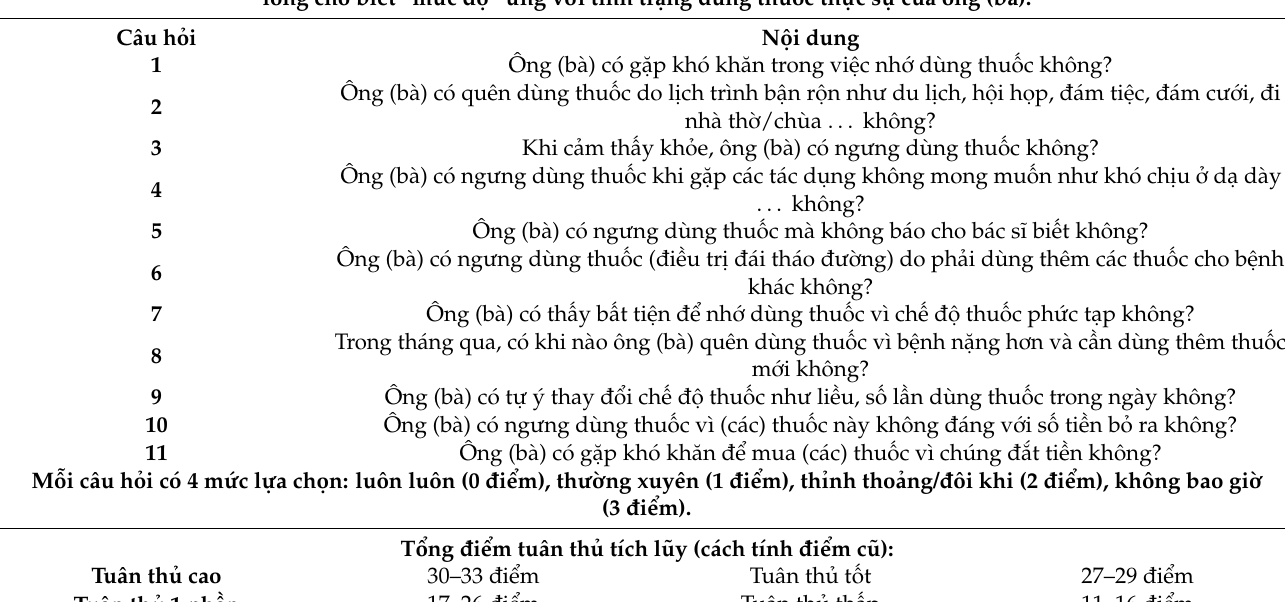
Table A3. The Vietnamese Version of the General Medication Adherence